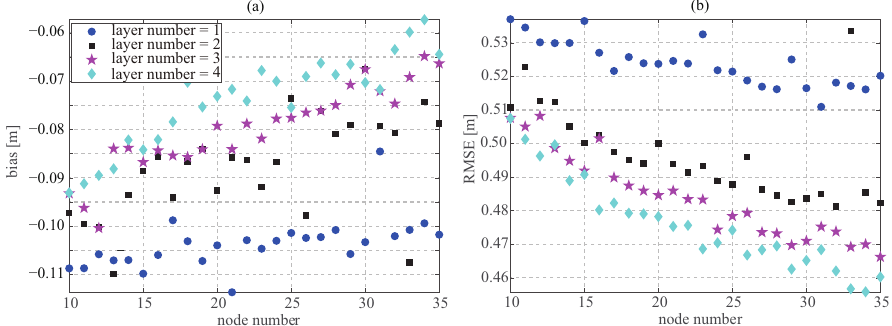
Figure 5. ( a ) Bias and ( b ) RMSE values for different numbers of hidden layers and numbers of neurons in each hidden